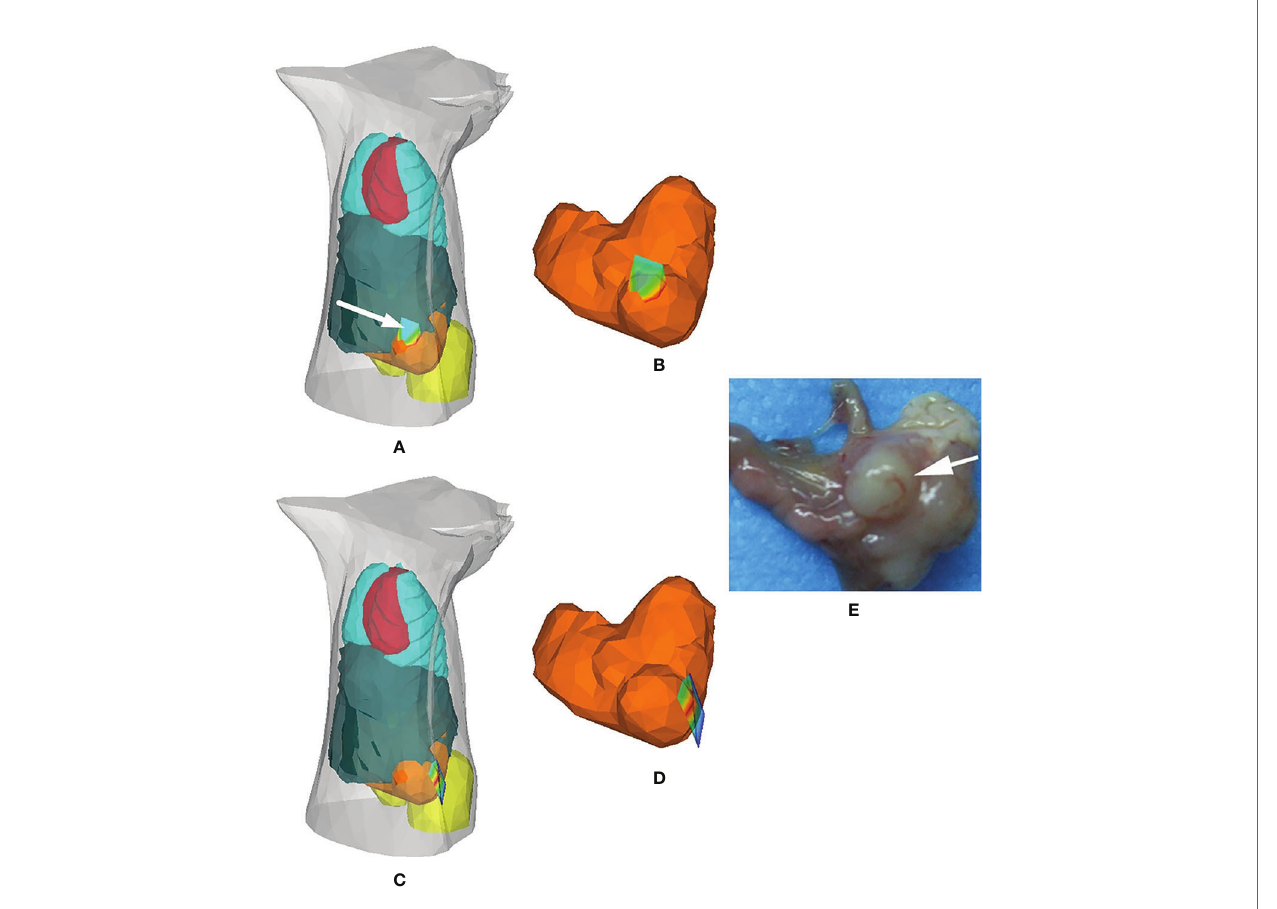
FIGURE 1 | Application of the hybrid radiosity-diffusion model in the detection of in situ gastric cancer. (A, B) Results of the HRDM-based BLT, (C, D) those of the DE-based BLT, and (E) the necropsy observation of the tumor lesion. Adapted with permission from